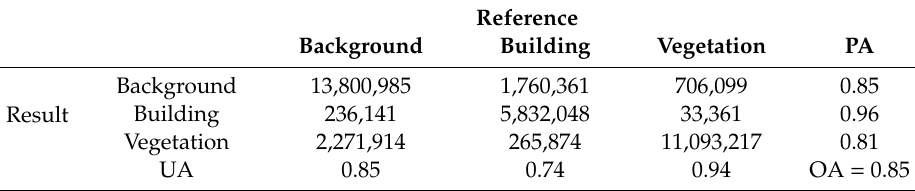
Table 9. Confusion matrix of SRM CNN result for Potsdam